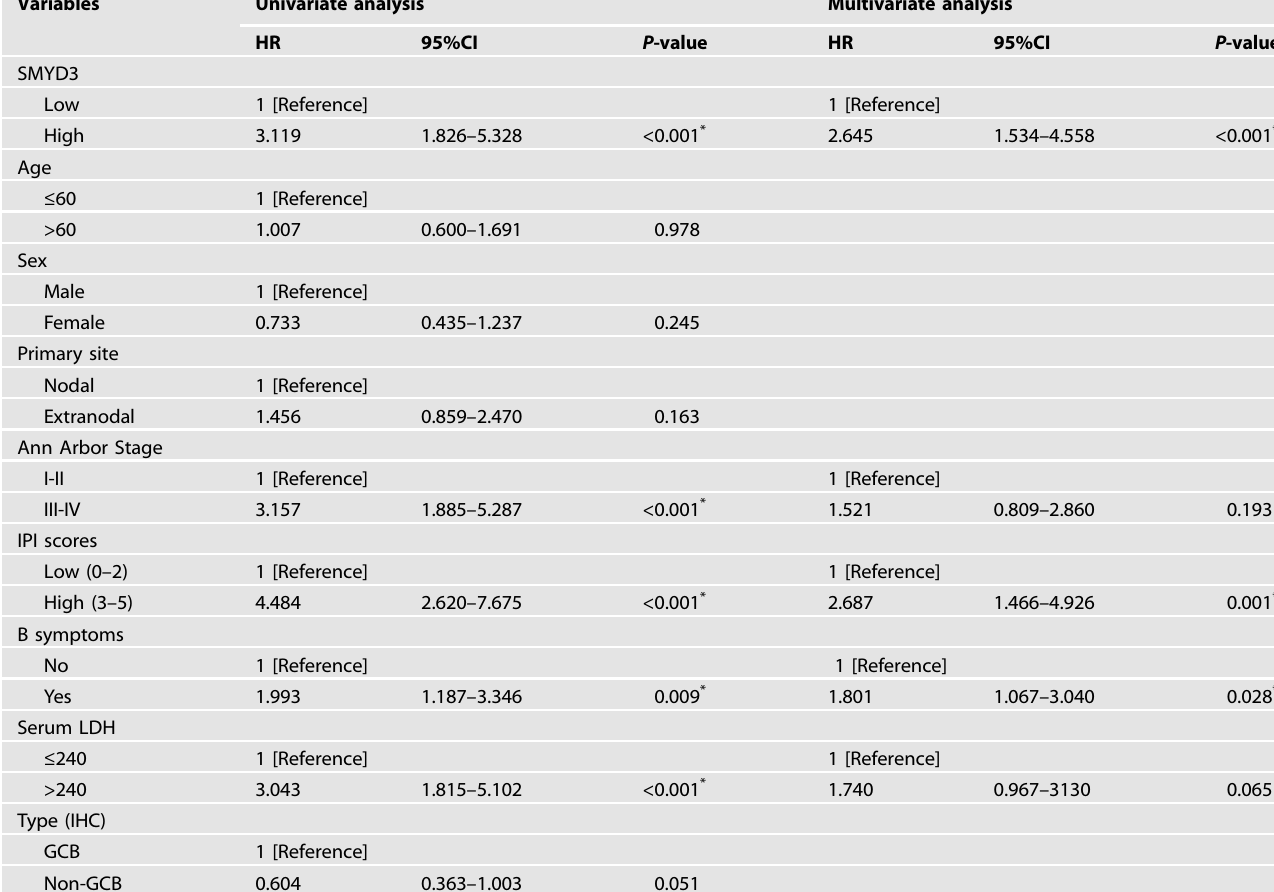
Table 3. Univariate and multivariate analysis for associations of SMYD3 protein expression with OS in DLBCLs.